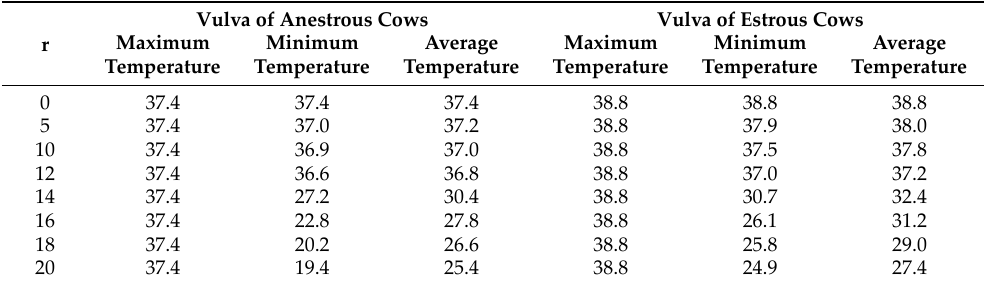
Table 3. Data table of maximum, minimum and average temperatures of the vulva of anestrous and estrous cows with different